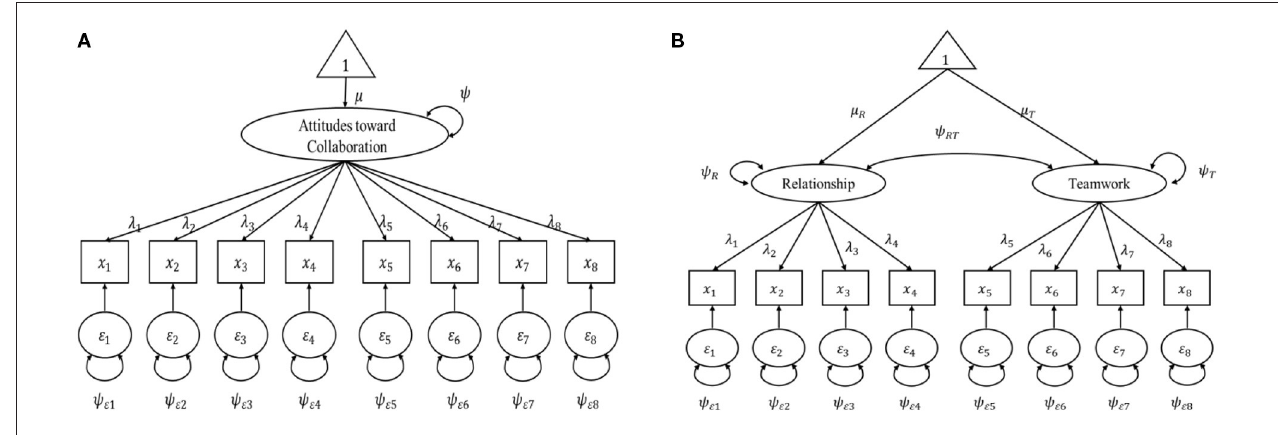
FIGURE 1 | Factor model for students’ attitudes toward collaboration. (A) One-factor model. (B) Two-factor model. µ , means of each latent factor within subgroup; ψ , residuals; λ , factor loadings.